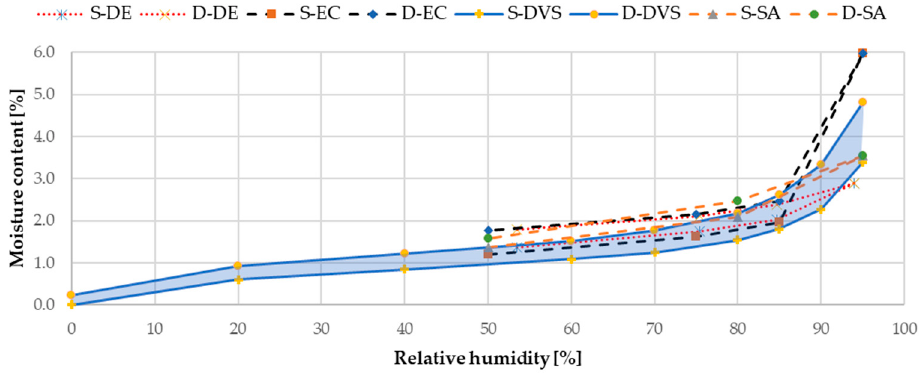
Figure 10. Sorption and desorption equilibrium points for the AC-6 sample.